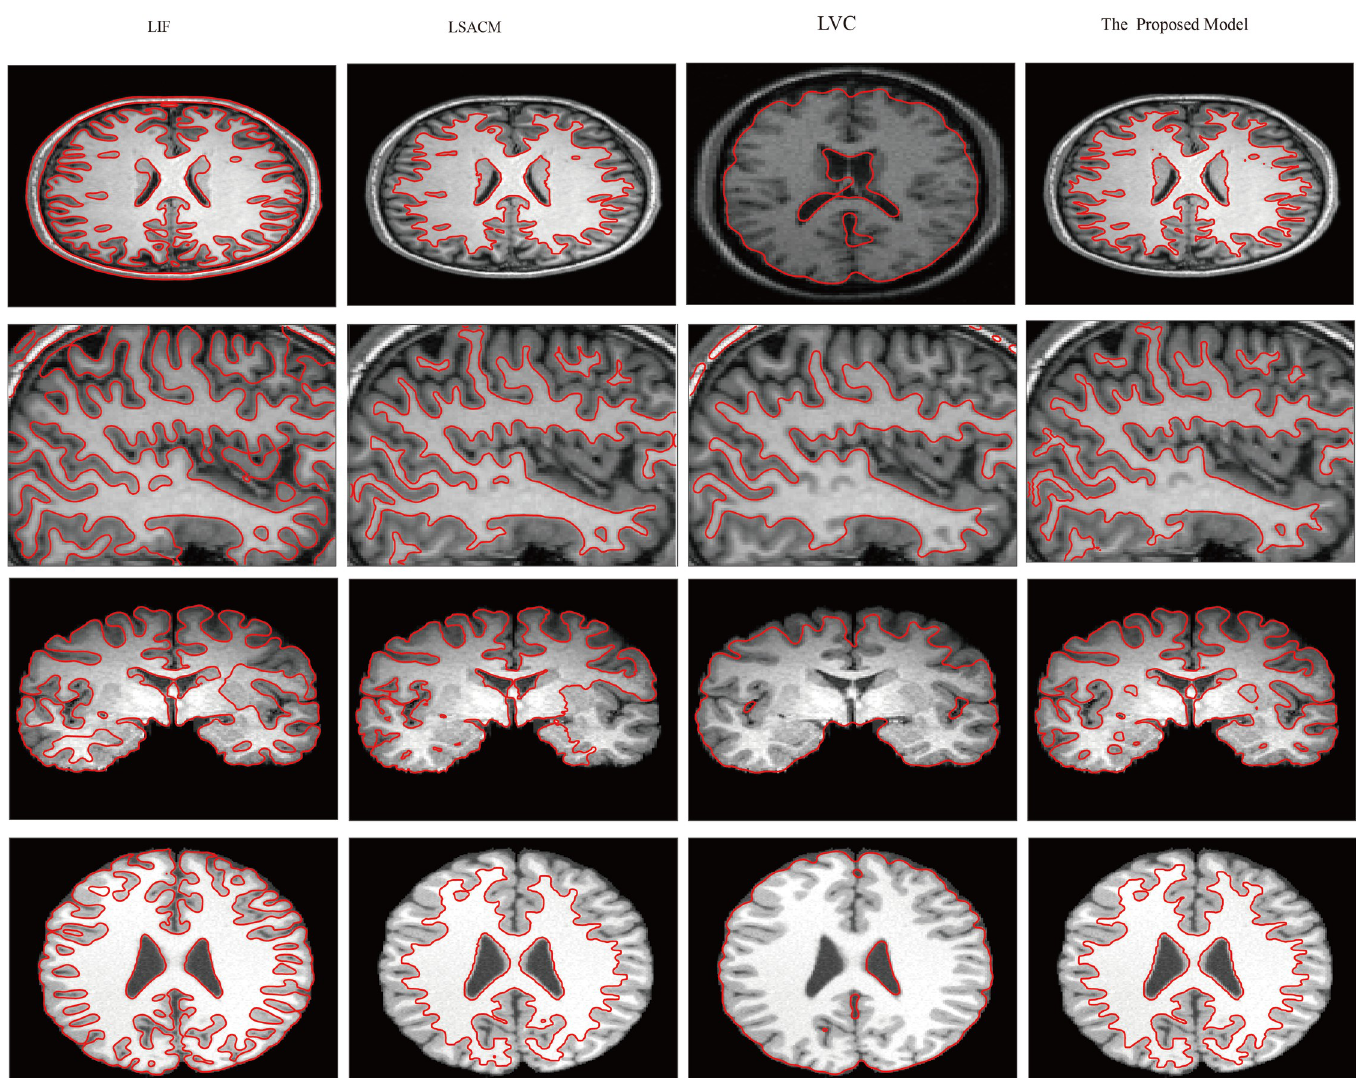
Fig 3. Comparisons of the proposed model with the LIF, the LSACM and the LVC on brain images.